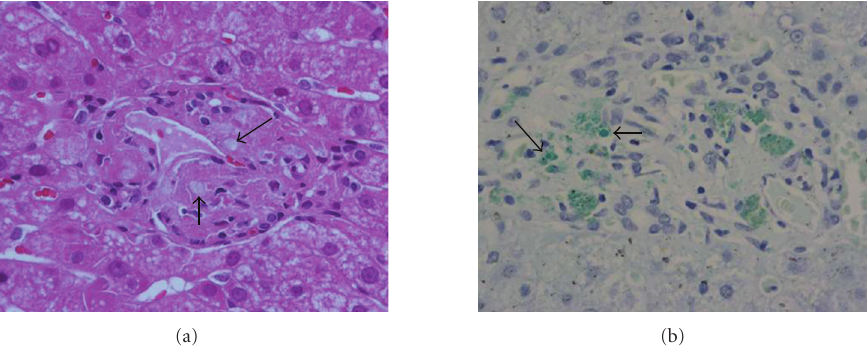
Figure 2: Photomicrographs of a liver biopsy. (a) Macrophages infiltrate into the portal area and contain achromatic fine granular depositions (arrows, hematoxylin, and eosin staining). (b) Fine granules are stained green in Leuco malachite green staining (arrows). Magnification, ×